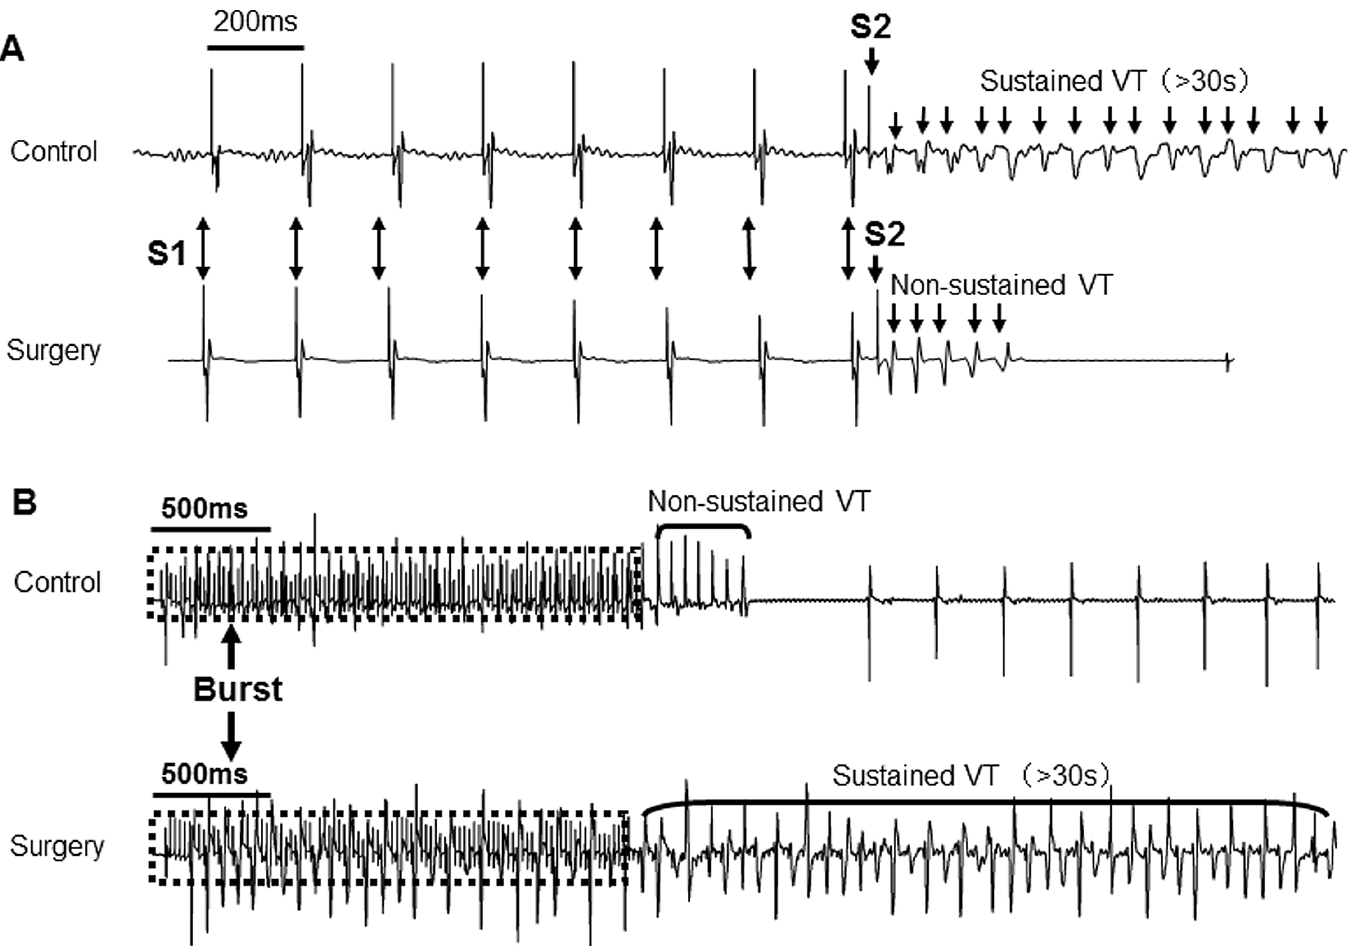
Fig 2. Ventriculartachyarrhythmias were inducedunder both PES (A) and burst stimuli (B), and the inducibilityin the surgery group was higherthan that in the control group. Polymorphicventriculartachyarrhythmias were observed in the surgery